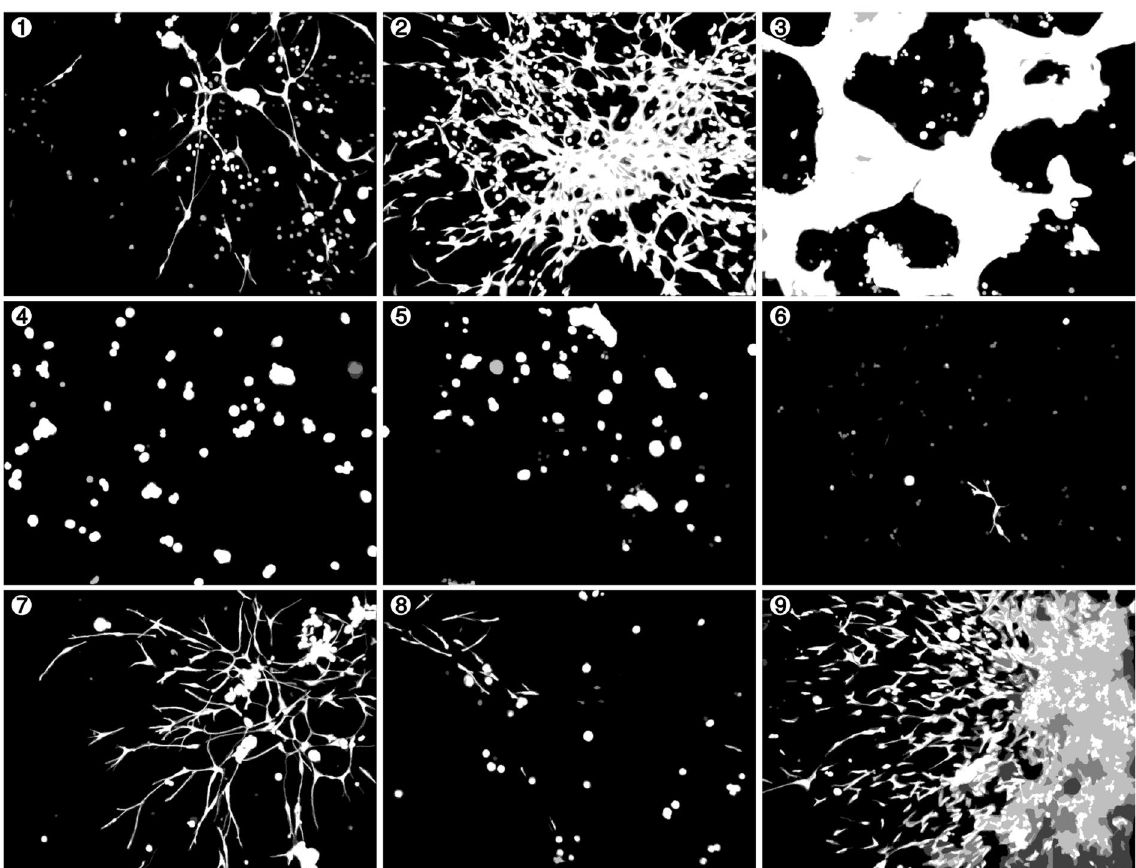
Figure 5. The manual thresholding for nine samples of confocal images averaged over the four experts PDX microtissue cultures are labelled in white (both tumor and stroma). White and black colors indicate a perfect agreement among the experts, whereas gray shades result from differing pixel